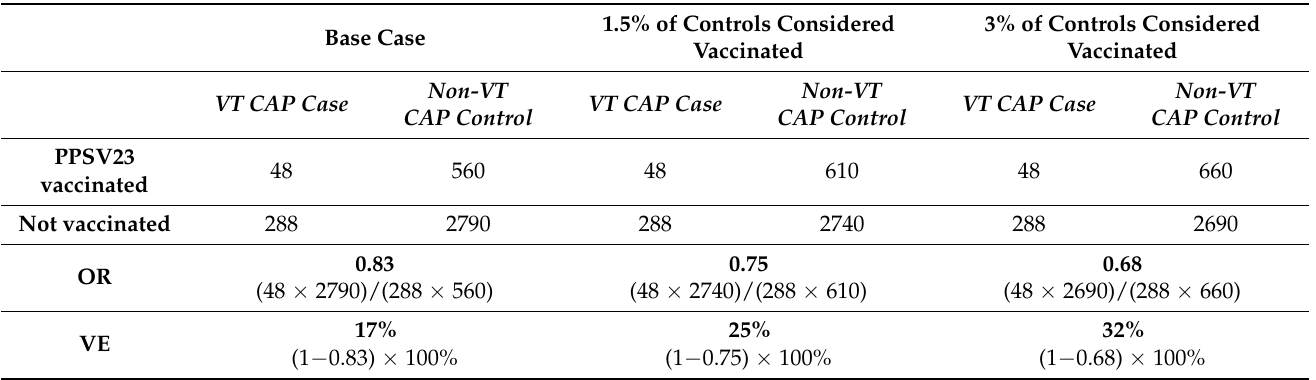
Table 1. Effect on vaccine effectiveness if 1.5% or 3% of the control population were considered